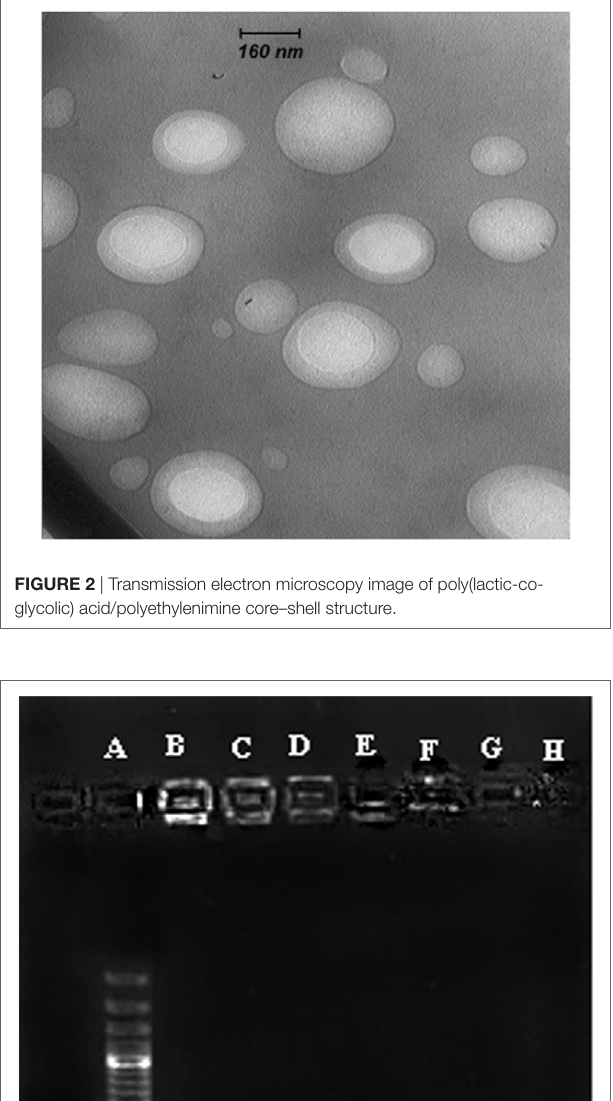
FigUre 1 | Scanning electron microscopy image of poly(lactic-co-glycolic) acid/polyethylenimine structure.